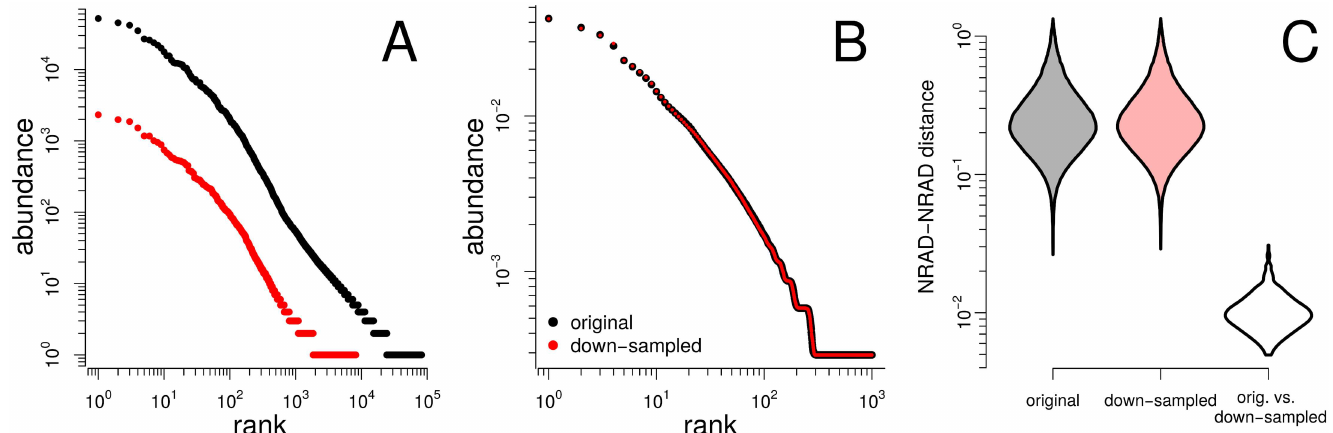
Fig 12. Robustness of NRADs against varying sampling depth. (A) originalRAD of first sample of [31] (black) and down-sampled RAD (red). (B) the two NRADs obtainedby MaxRanknormalization to R = 1000 of the RADs in panel A are almost indistinguishable. (C) comparisonof NRAD distances of the first 50 samples of the data set of [31]. Left violinplot: density of distances betweenNRADs computedby MaxRanknormalization to R = 1000 of the originalRADs; middle violin plot: same for down-sampled RADs; right violin plot: distances betweencorresponding originaland down-sampled NRADs. The biologicallymeaningful NRAD distancedistributionsare robust against differences in sample size (left and middle violin).In comparison, the distances related to differences in sample size are negligible(right violin).